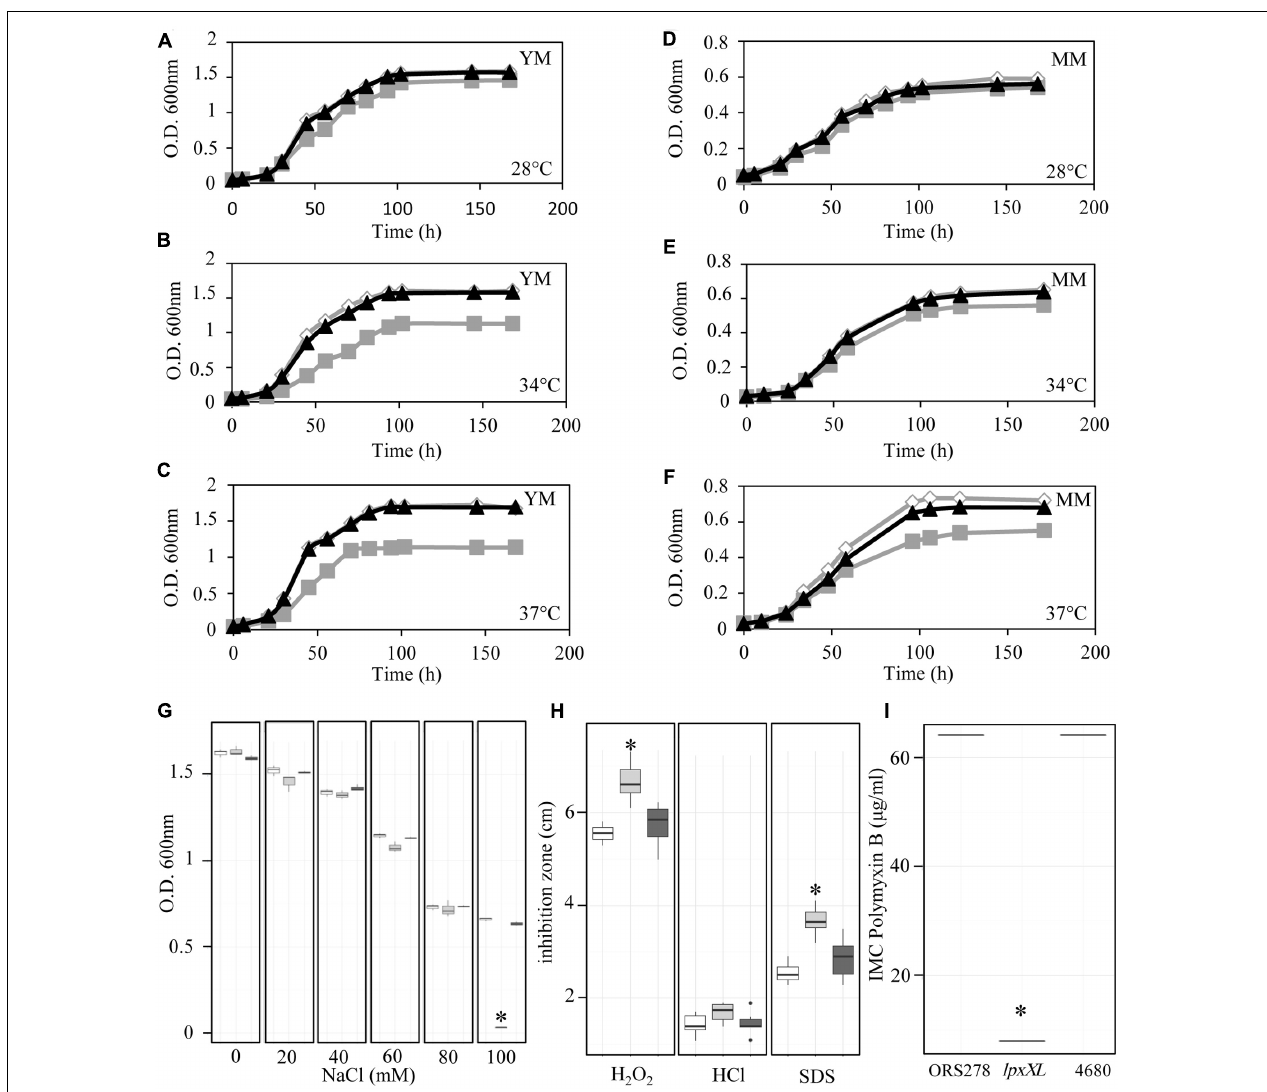
FIGURE 4 | The lack of C 26 :25OH VLCFA affects the physiology of ORS278 in free-living state. (A–F) Growth kinetics of ORS278 (white), lpxXL (gray), and BRADO4680 (black) mutants in (A–C) YM medium and (D–F) Minimal medium at 28 ◦ C (A–D) , 34 ◦ C (B–E) and 37 ◦ C (C–F) , The experiment was carried out in duplicate. (G) Box plots representation of the NaCl resistance of ORS278 (white), lpxXL (gray) and BRADO4680 (dark gray) strains cultivated in rich medium (YM), at 34 ◦ C ( n = 3). (H) Box plots representation of the hydrogen peroxide (H 2 O 2 ), hydrogen chloride (HCl) and sodium dodecyl sulfate (SDS) resistance of ORS278 (white), lpxXL (gray) and BRADO4680 (dark gray) mutants, as determined by disk diffusion assays using 5 µ l of 5.5 M H 2 O 2 , 2N HCl or 10% of SDS ( n = 9). (I) Box plots representation of the polymyxin B resistance of ORS278 and the lpxXL and BRADO4680 mutants, determined by Etest (Etest R (cid:13) bioMérieux) on YM medium ( n = 3). (G–I) ∗ P < 0.01, by Tukey’s honestly significant difference